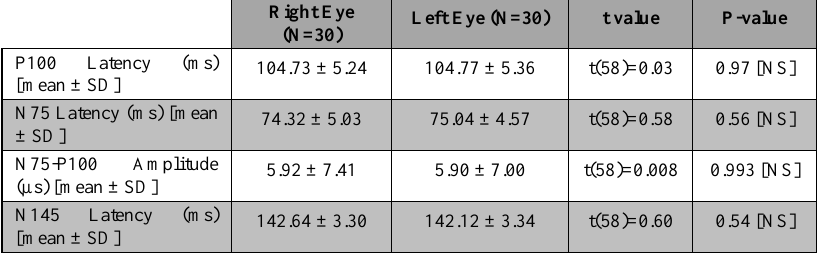
Table 7. Comparison of N75-P100 amplitude of VEP wave latencies between two eyes of cases.